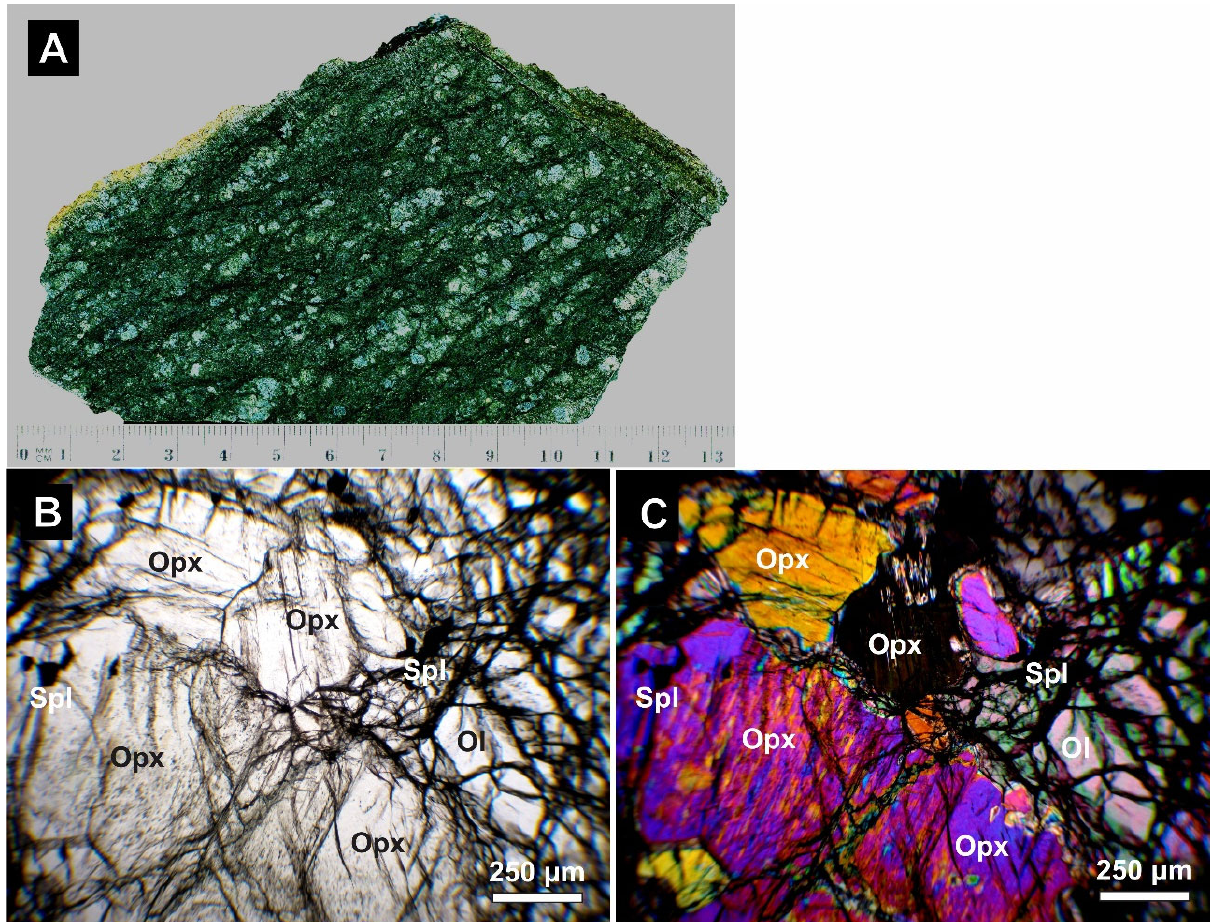
Figure 6. Macroscopic and PL microscopic images of harzburgite (P21). ( A ) Cut surface shows macroscopic anisotropy defined by Px porphyroclasts in soft, serpentinized Ol-rich matrix. ( B , C ) Opx porphyroclasts with exsolutions in partly recrystallized and serpentinized Ol matrix. Picture ( A ) at II P; ( B ) at X P.